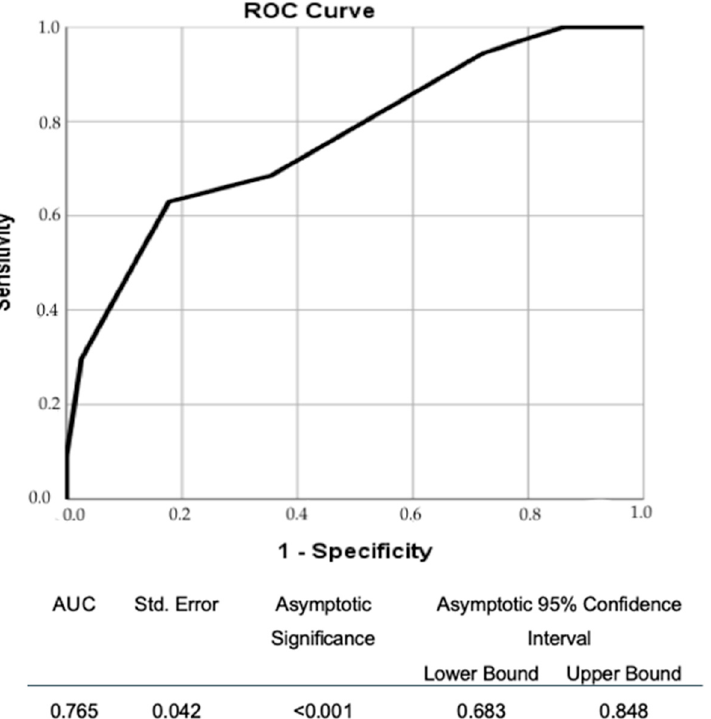
Figure 2. Receiver operator characteristic curve for the relation between diameter stenosis severity (based on 7-degree classification according to the decision of the majority) and the functional significance (FFR ≤ 0.8)